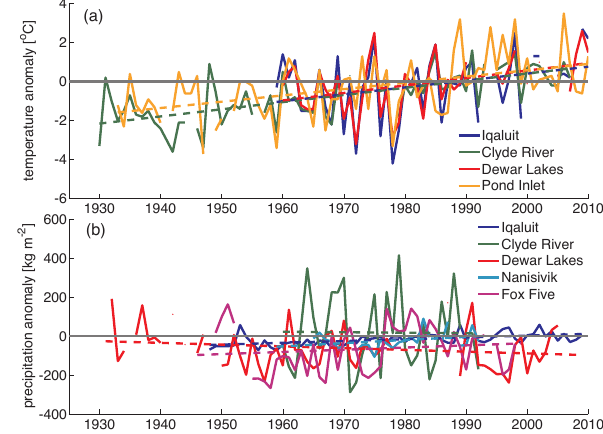
Fig. 9. (a) Summer (June, July, August) temperature and (b) annual precipitation anomalies relative to the 1981–1990 mean (optimal period of overlap). Dashed lines show linear trends fitted to all data from each